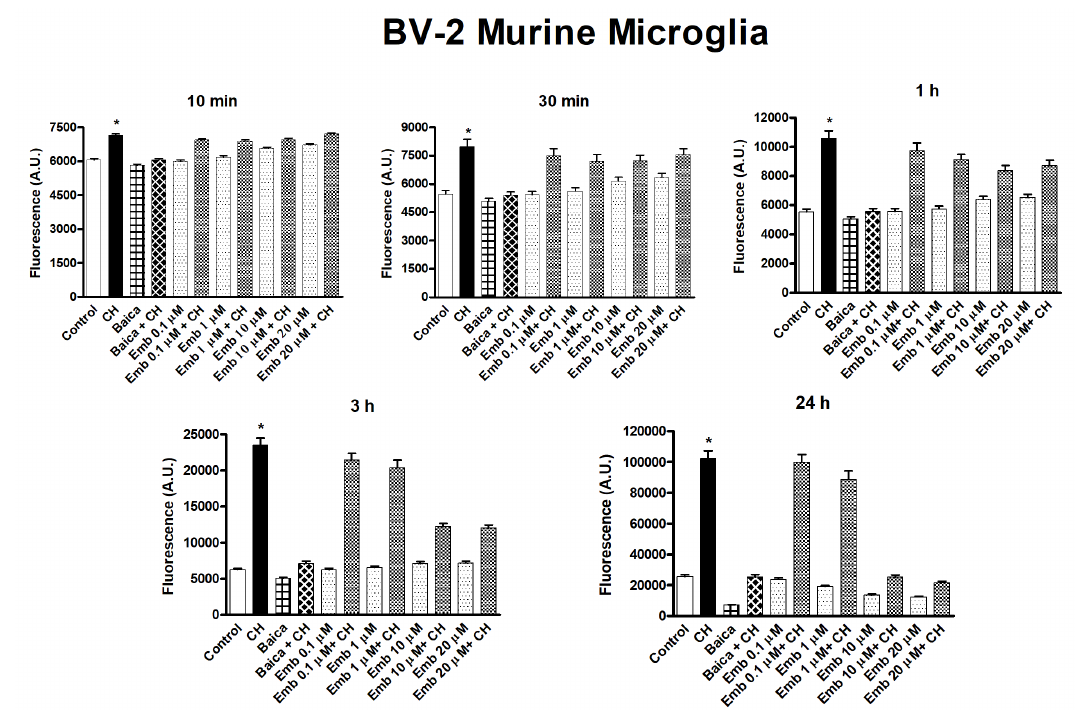
Figure 18. Time course of embelin capability to protect toward oxidative stress given by Cumene hydroperoxide in BV-2 murine microglia cells. The concentration of cumene hydroperoxide (CH) was 200 µ M for both cell lines. Before the addition of cumene hydroperoxide, cells were pre-incubated with embelin (0.1 µ M–20 µ M) at 37 ◦ C for 10 min, as reported in Section 2.6. Baicalein 10 µ M was used for both cell lines, as reference compound, showing a very good antioxidant activity [18]. The results are mean ± SD of at least three di ff erent experiments carried out in quintuplicate on 96 wells plates. A period of 10 min, 30 min, * p < 0.01, at least, vs. all but embelin + CH; 1 h, 3 h, 24 h, * p < 0.05 at least, vs. all but embelin 0.1 µ M + CH and embelin 1 µ M + CH. We also carried out the proliferation curve both with BV-2 and THP-1 monocytes in the presence and absence of embelin and at the concentrations employed. The cell proliferation was not a ff ected by embelin in both cell lines (Figures 21 and